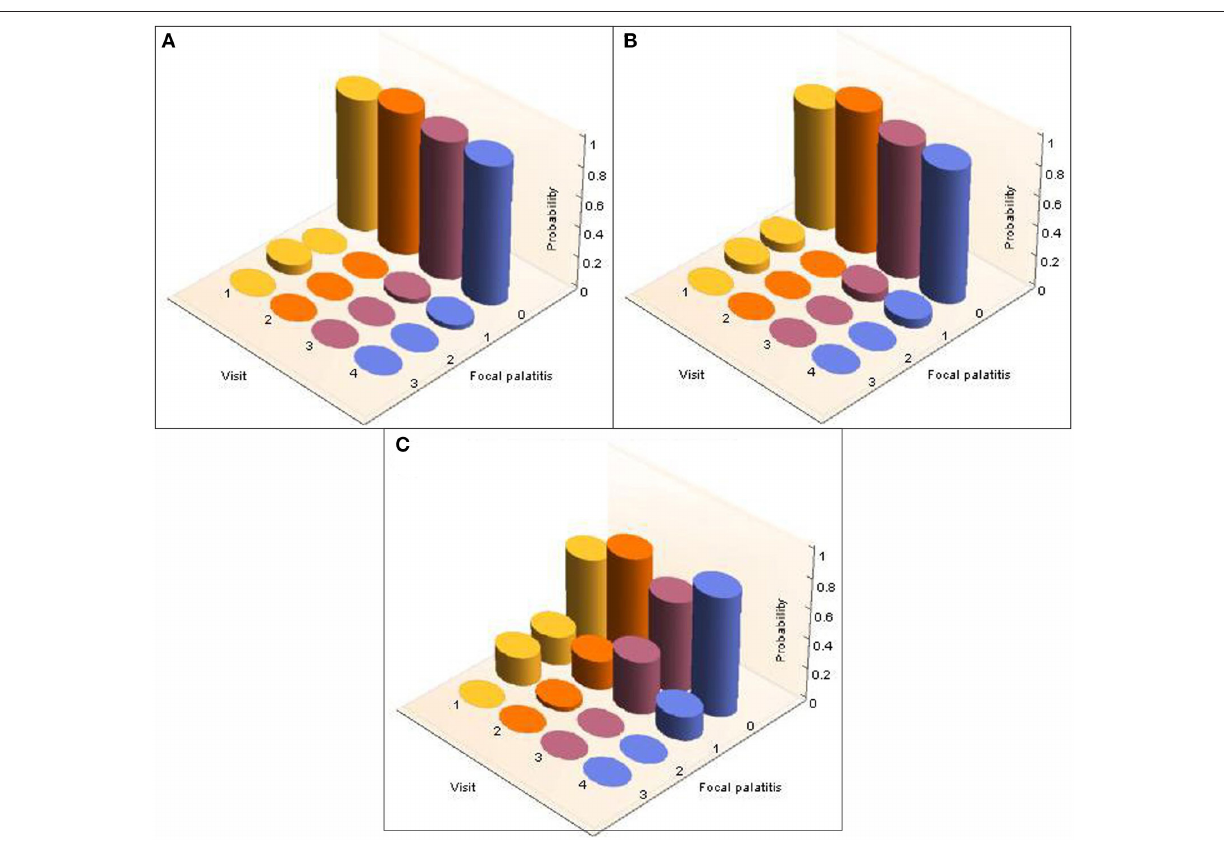
FIGURE 3 | 3-D column charts depicting the development of FP in terms of occurrence and severity in cheetahs from AfriCat (AF), evaluated on four different, consecutive visits. The probabilities of the development of FP in each of the palatal depressions that can potentially have FP are shown. Note that dRPM2 and dLPM2, dRPM3 and dLPM3, and dRPM4 and dLPM4 were pooled. (A) Shows FP at the depressions palatal to the maxillary 2nd premolar teeth, (B) shows FP at the depressions palatal to the 3rd maxillary premolar teeth, (C) shows FP at the depressions palatal to the 4th maxillary premolar